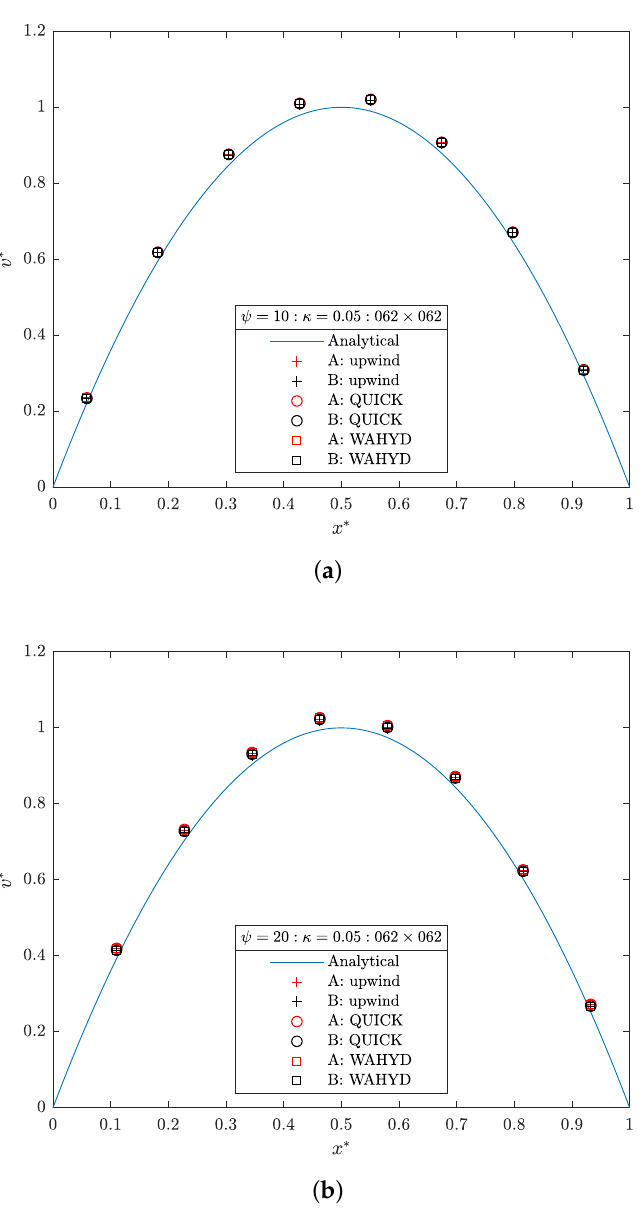
Figure 22. Dimensionless velocity profile for the flow on inclined channel case. ( a ) ψ = 10; ( b ) ψ = 20. Figures 23 and 24 present the computational efficiency obtained for the cases studied as a function of κ . Different from the tendency shown in the flow between concentric cylinders case, the higher efficiency values are obtained with the mid-to-high values of κ . This difference may be due to the type of curve that represents the immersed solid body, which in the present case are two straight lines, whereas in the former case they were circumferences. Nevertheless, the maximum-to-minimum computational efficiency ratio is higher for the flow between concentric cylinders case than in the present one, suggesting a greater effect of κ on the computational efficiency when the streamlines are